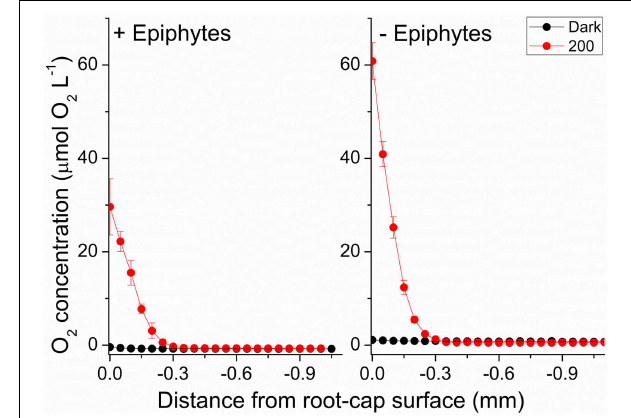
FIGURE 7 | Radial O 2 loss from the root-cap of Z. marina ( ∼ 1mm from the root-apex) to the immediate rhizosphere measured at two different photon irradiances (0 and 200 µ mol photons m − 2 s − 1 ). Left panel show radial O 2 loss from seagrass with leaf epiphyte-cover, right panel show radial O 2 loss from seagrass without leaf epiphyte-cover. X = 0 indicates the root surface. Error bars are ± SD. n = 3 –5; root level